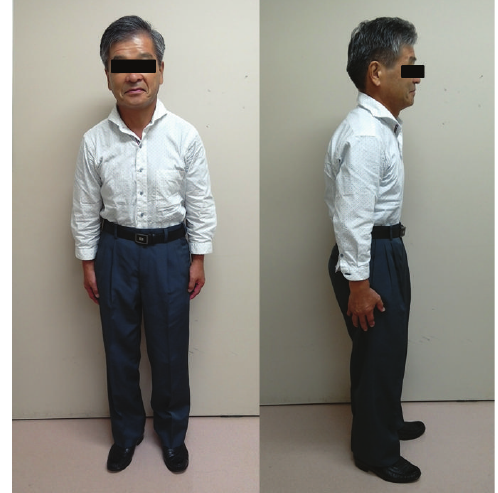
Figure 1: Photographs of the patient in a standing position. He was short, only 149 cm in height.